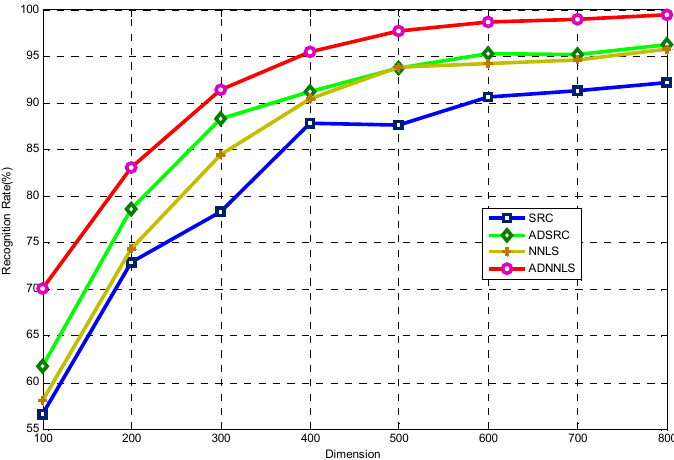
Figure 12. Recognition performance of the four algorithms with varying feature dimensions.